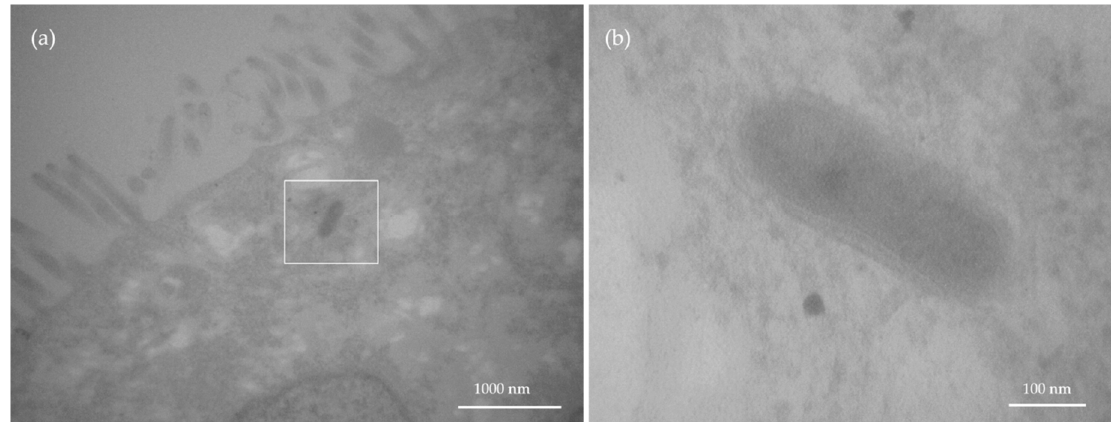
Figure 6. TEM image of an internalized AuNRod in the gastrointestinal in vitro model. After AuNRod exposure, the in vitro model was investigated by TEM. ( a ) Section through the cell model. ( b ) Enlargement of the area marked in ( a ). Clearly visible here is the membrane bilayer around the AuNRod, through the protein corona and the vesicle membrane.